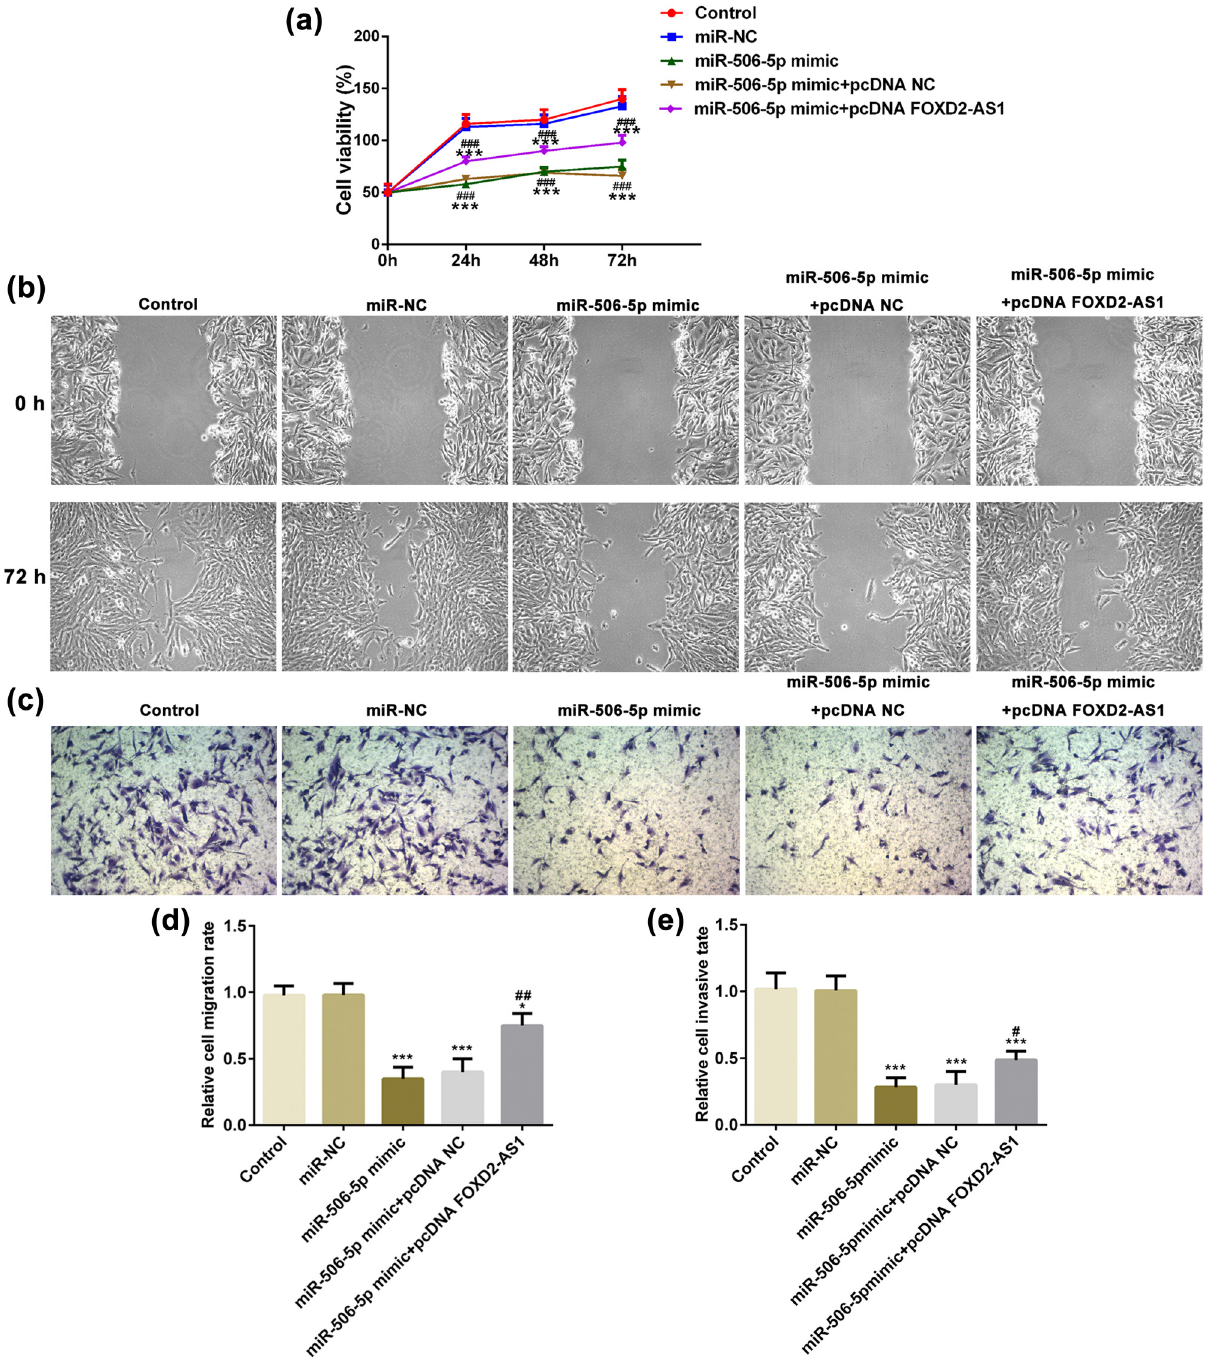
Figure 4: FOXD2 - AS1 promotes glioma progression via regulating miR - 506 - 5p. ( a ) miR - 506 - 5p upregulation inhibited U251 cell proliferation, while pcDNA - FOXD2 - AS1 abolished the e ff ects. ( b and c ) miR - 506 - 5p mimic suppressed the cell migration of U251 cells, while pcDNA - FOXD2 - AS1 reversed the changes. Magni fi cation × 200. ( d and e ) Quantitative analysis results of relative migration and invasive rates. N = 5, * P < 0.05 and *** P < 0.001 vs. miR - NC and control; # P < 0.05, ## P < 0.01 and ### P < 0.001 vs. miR - 506 - 5p mimic and miR - 506 - 5p mimic + pcDNA -